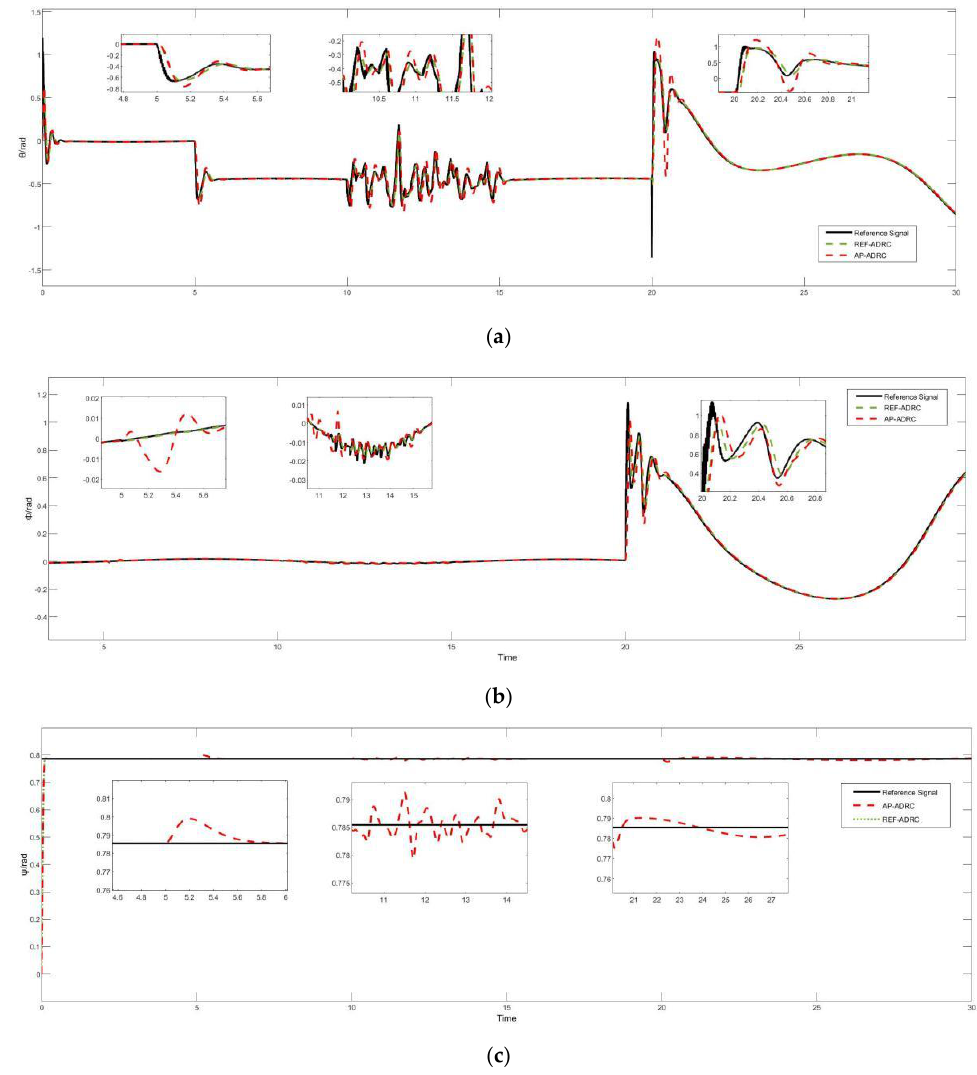
Figure 7. Attitude control response curves under three disturbances.( a – c ) are the tracking curves for the three attitude control channels.